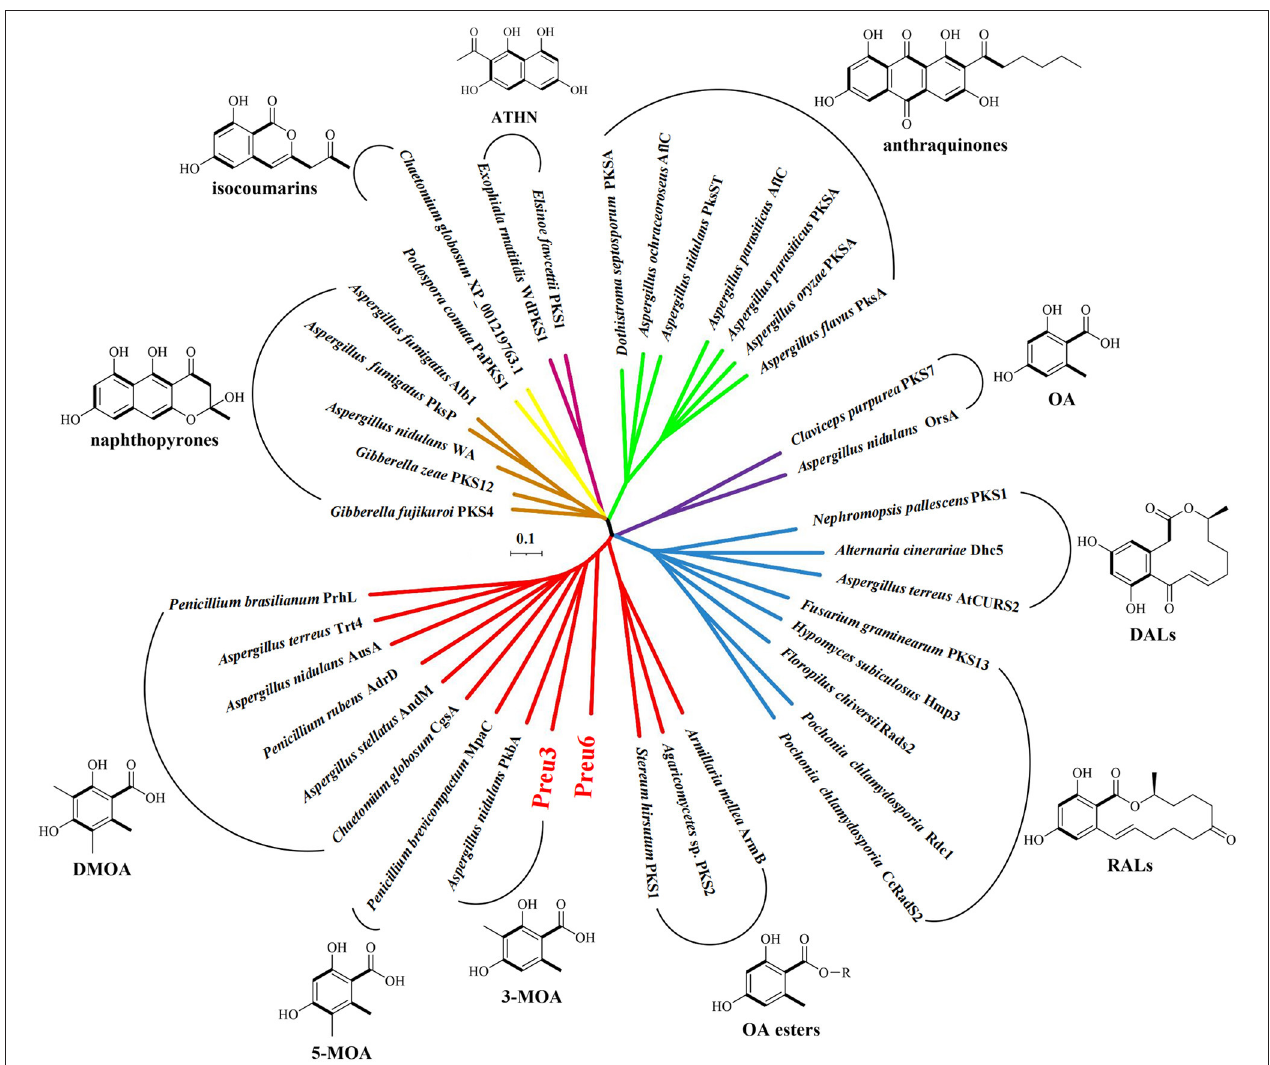
FIGURE 4 | Phylogenetic network of representative fungal nrPKSs. Phylogenetic trees for the selected characterized nrPKSs, which are involved in the biosynthesis of the representative polyketides (Lackner et al., 2013; Hussain et al., 2017; Wang et al., 2020), including naphthopyrones (brown), isocoumarins (yellow), ATHN (maroon), anthraquinones (green), DALs (blue), RALs (blue), OA (purple), and its derivatives (red) covering 3-MOA, 5-MOA, DMOA, and OA esters. For accession numbers, see Supplementary Table S6 .